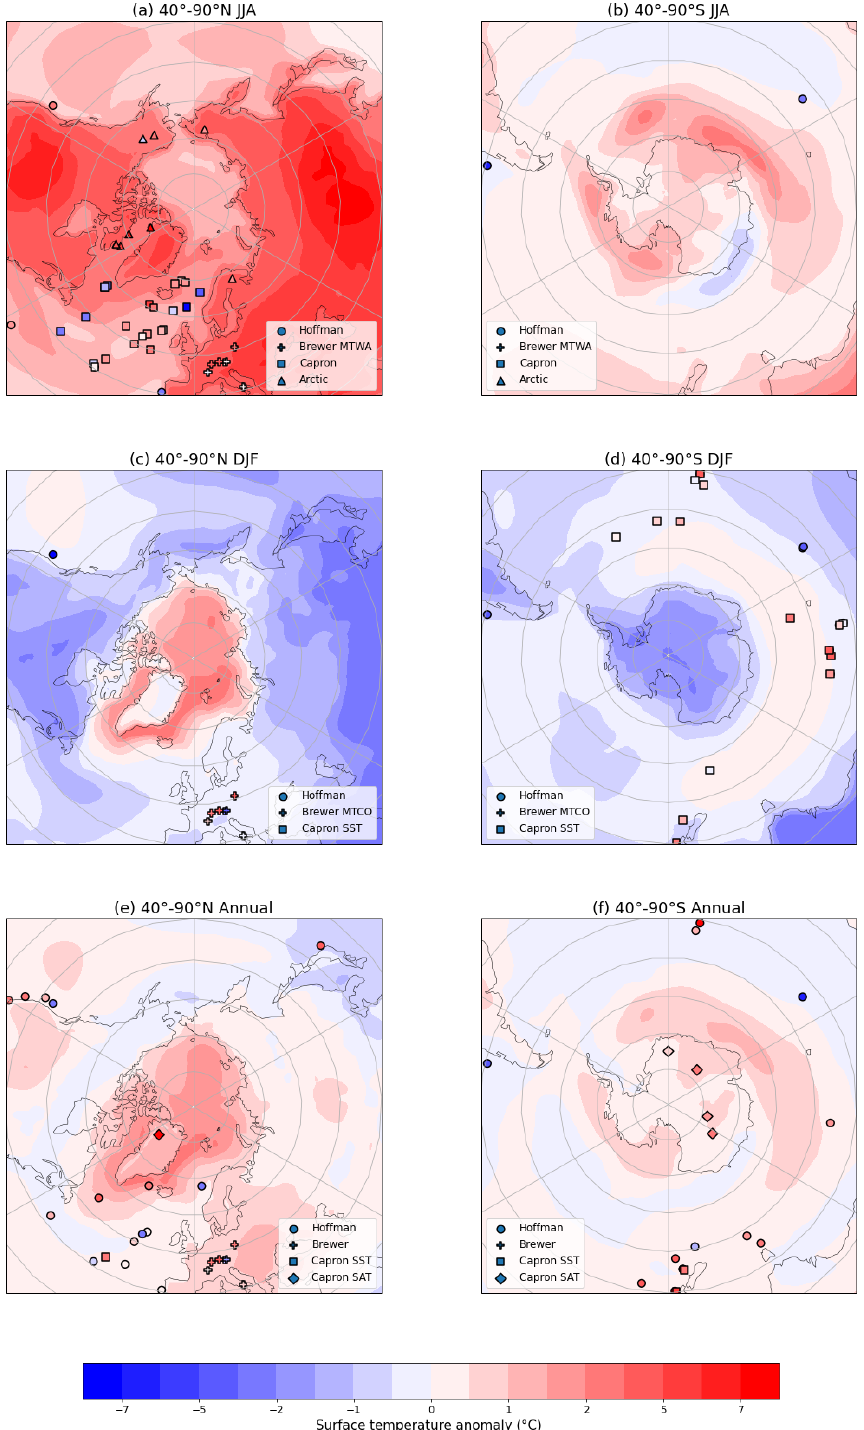
Figure 10. High-latitude surface temperature anomaly between 127ka and the preindustrial from models (ensemble average in colors) and proxies (filled markers): circles for the compilation by Hoffman et al. (2017), squares and diamonds for marine sites and ice cores, respectively, of the compilation by Capron et al. (2014, 2017), pluses for the compilation of Brewer et al. (2008), and triangles for the Arctic compilation. (a, b) June–July–August; (c, d) December–January–February; and (e, f) annual. The preindustrial reference is 1850CE for model anomalies, and for the data it is 1870–1899 for Capron, Brewer, and Arctic; 1870–1889 for Hoffman.